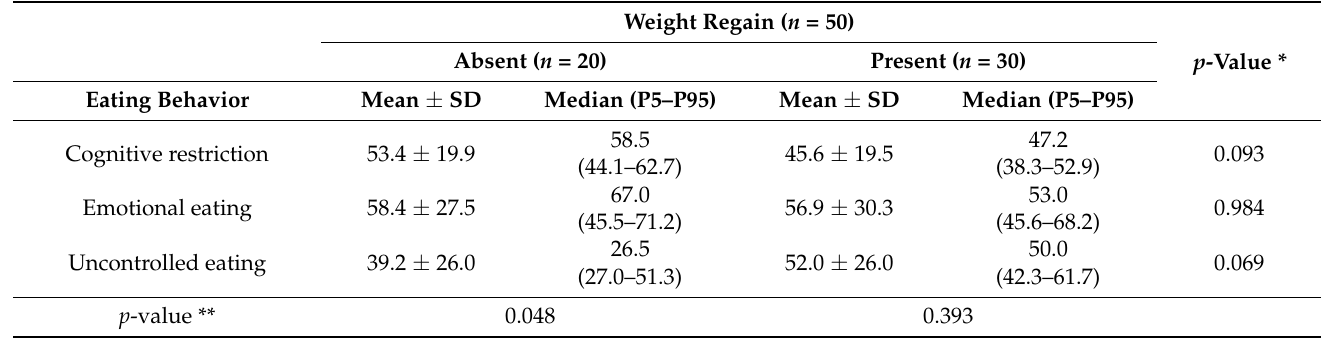
Table 2. Eating behavior and QOL according to the presence or absence of weight regain in women with more than 24 months of